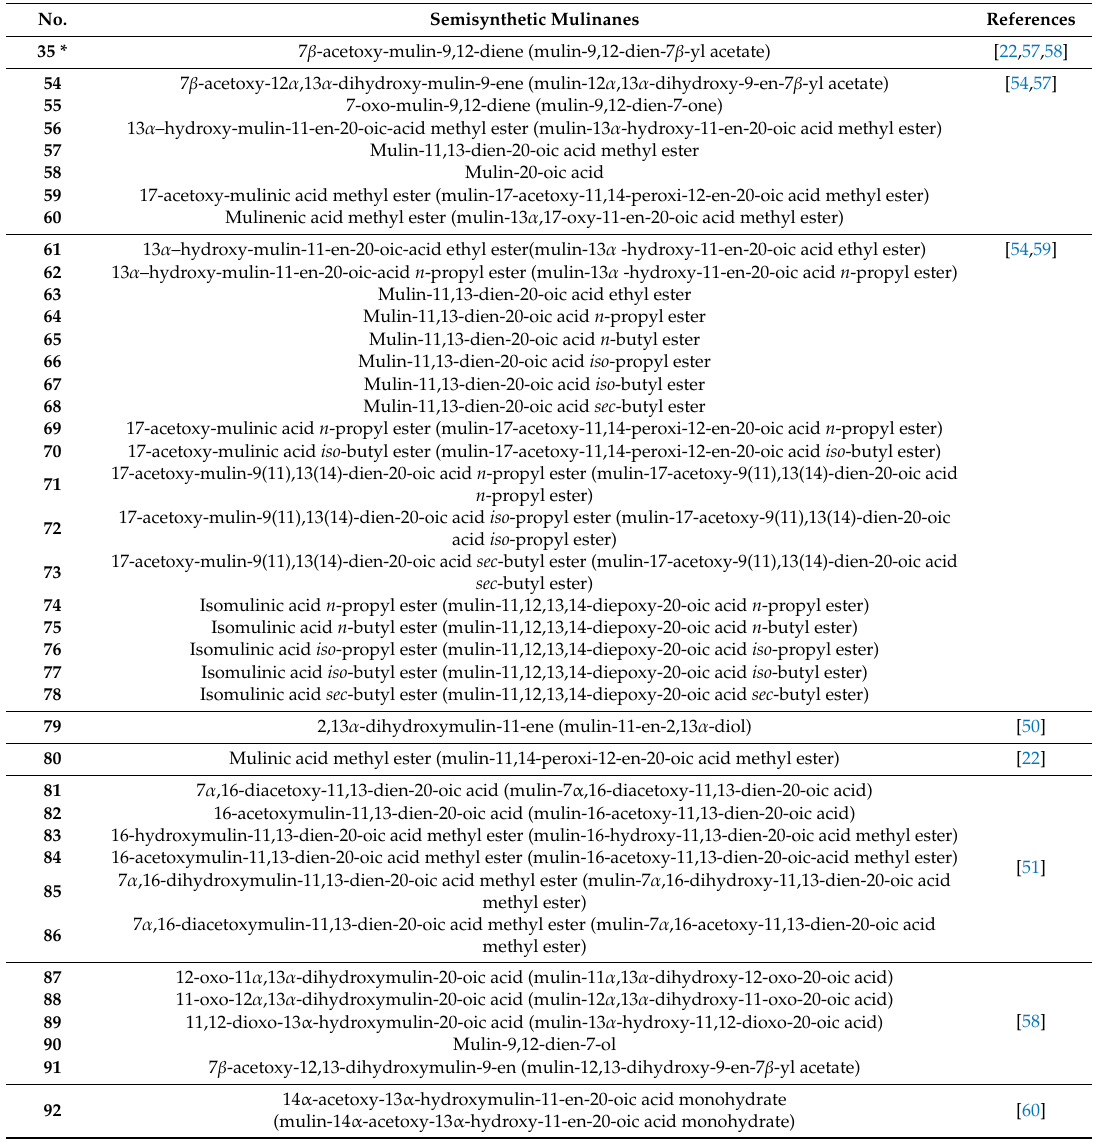
Table 3. Semisynthetic derivatives of